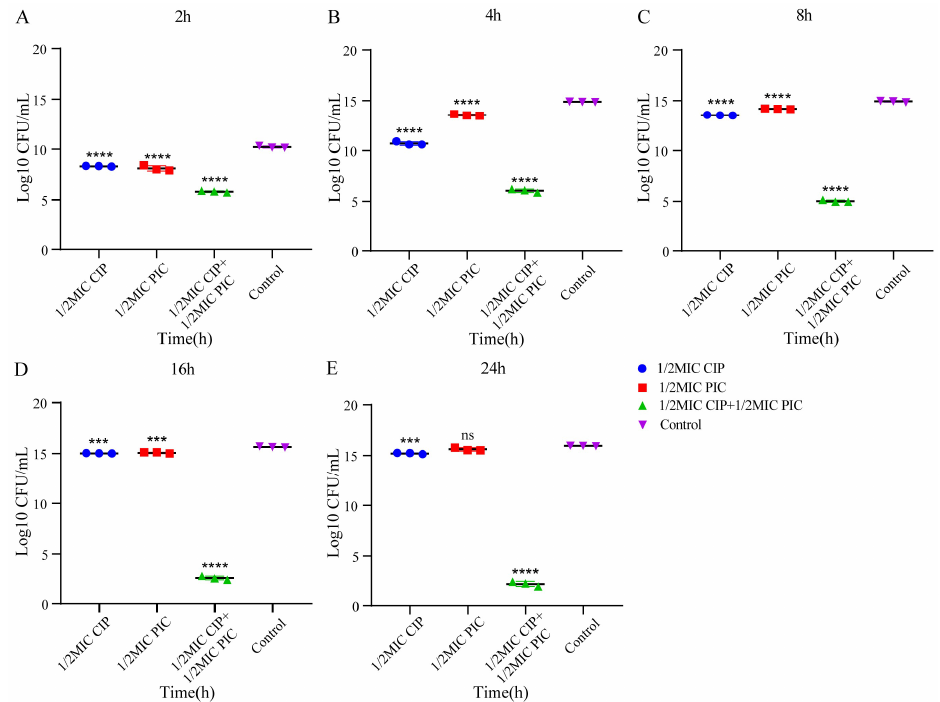
Figure 2. Statistical analysis of bacteria colonies of S. aureus ATCC 29213 at different times. ( A ) 2 h, ( B ) 4 h, ( C ) 8 h, ( D ) 16 h, ( E ) 24 h. n = 3. Results from all experiments are presented as the mean ± SD of three replicates. ns= p > 0.05, ***= p < 0.001, ****= p < 0.0001.